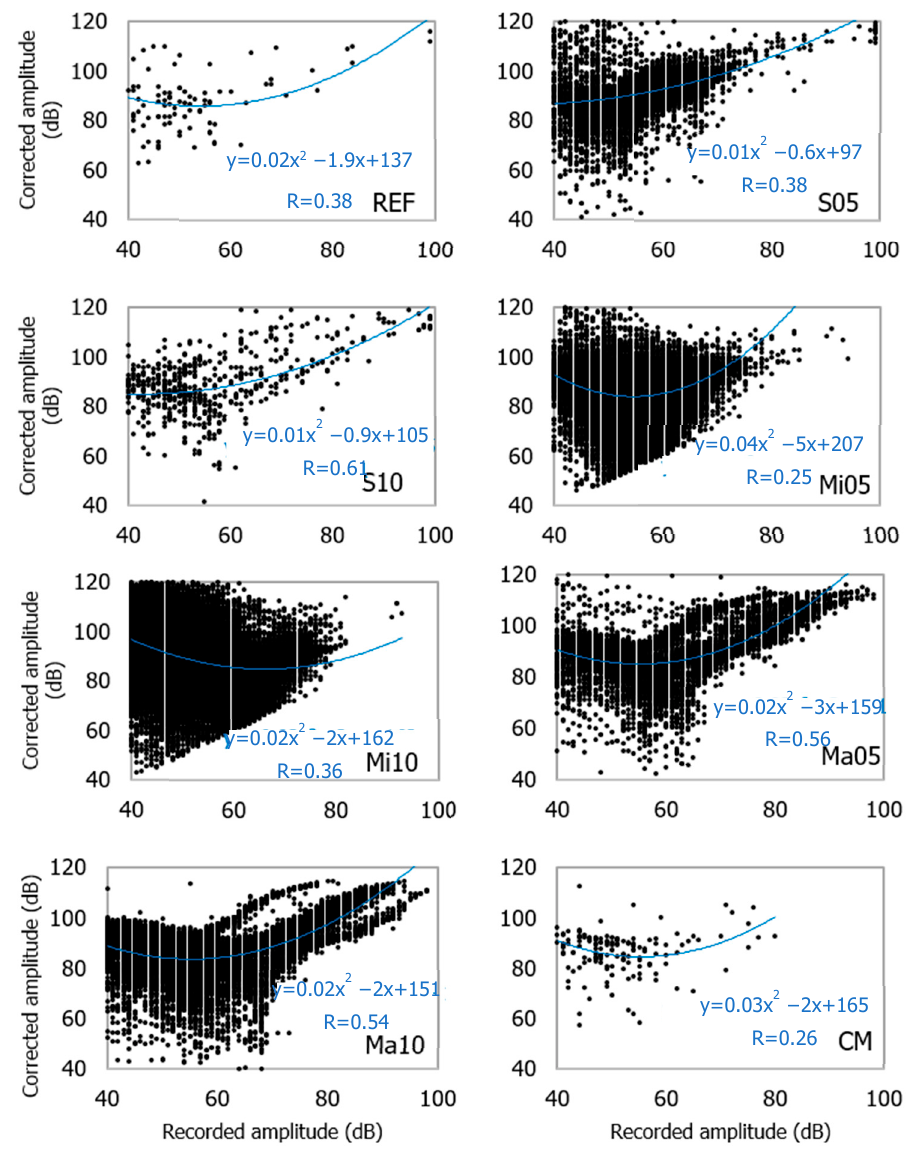
Figure 9. Recorded vs. corrected amplitude relations.